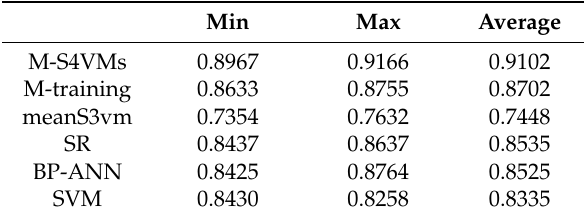
Table 10. Outcomes of the six semi-supervised algorithms.